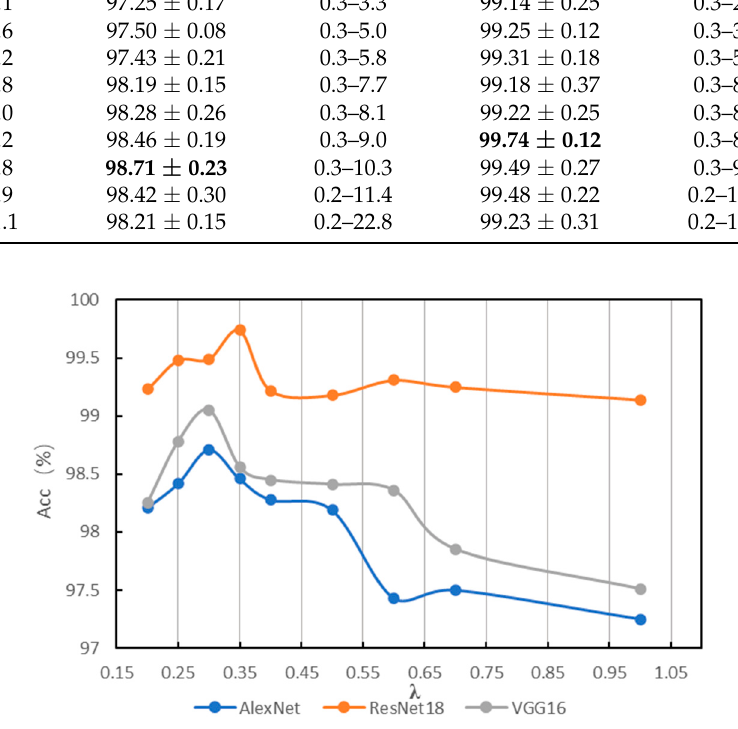
Figure 7. JNU accuracy of IG ‐ CWT and CWT.